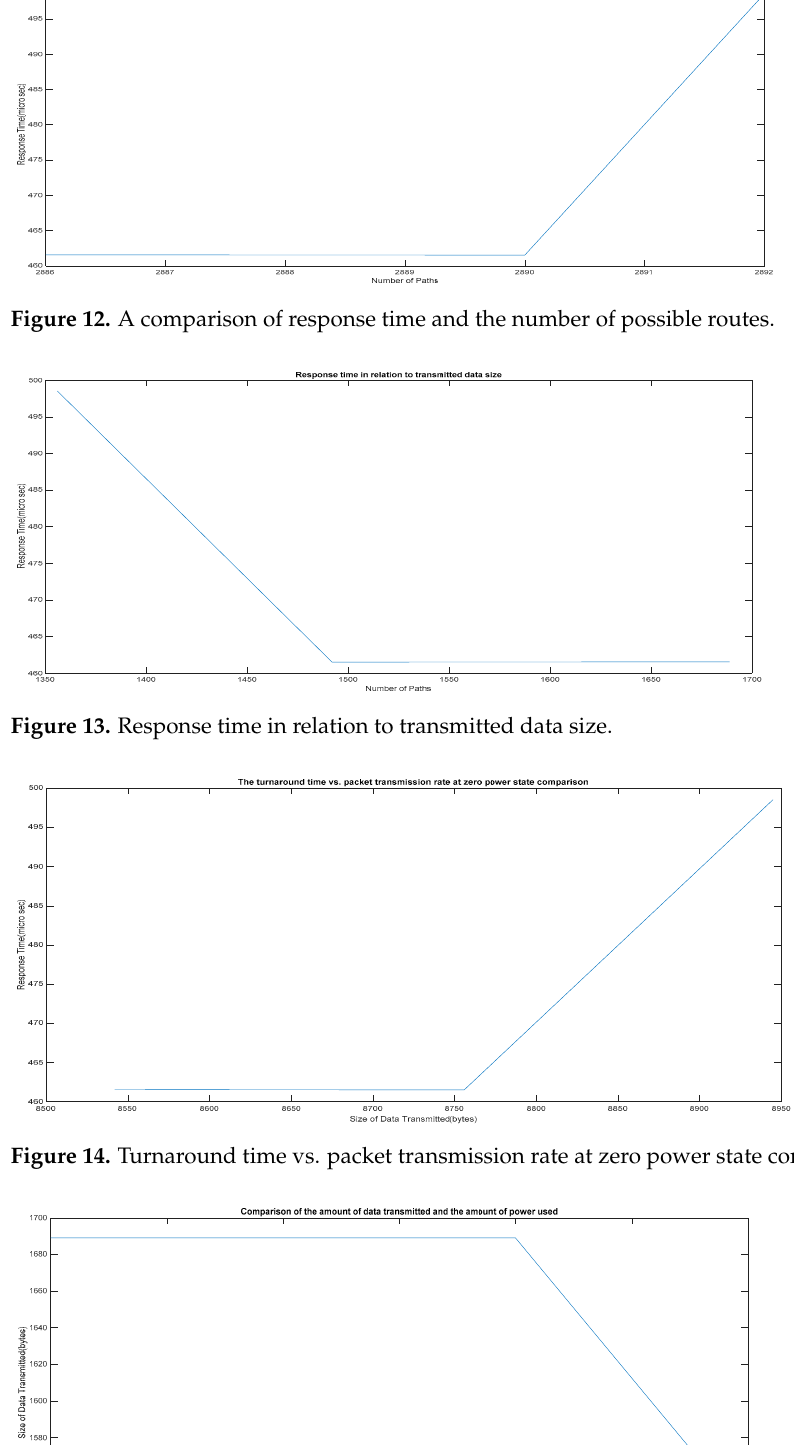
Figure 15. Comparison of the amount of data transmitted and the amount of power